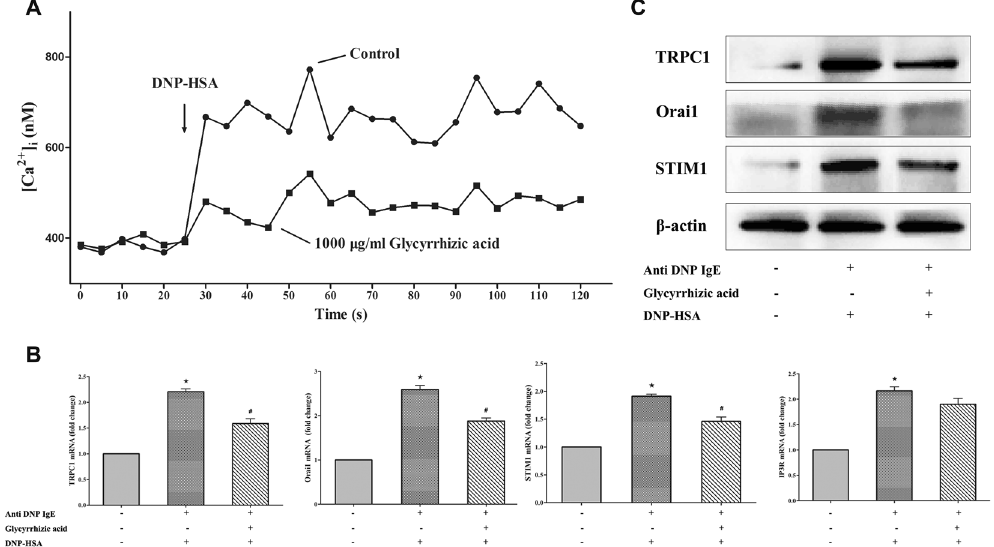
Figure 6. GA blocked the exCa 2 + influx to stabilize RBL-2H3 through reducing calcium channel proteins expression. * P < 0.05, significantly different from control and # P < 0.05, significantly different from sensitization control without GA treatment (n = 3). ( A ) Effect of GA on [Ca 2 + ] i . ( B ) The mRNA relative expression of Orai1, STIM1, TRPC1 and IP3R. ( C ) The protein expression of calcium channel